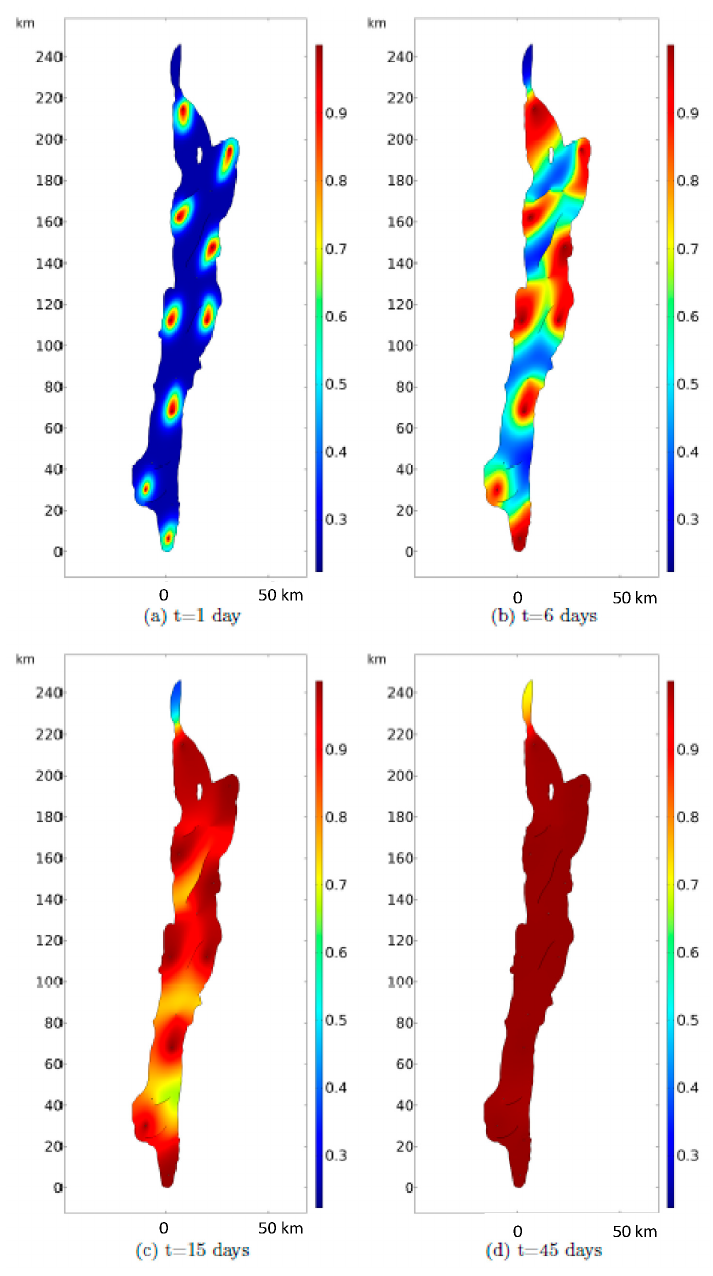
Figure 15. Normalized polymer solution saturation at four different time steps of the